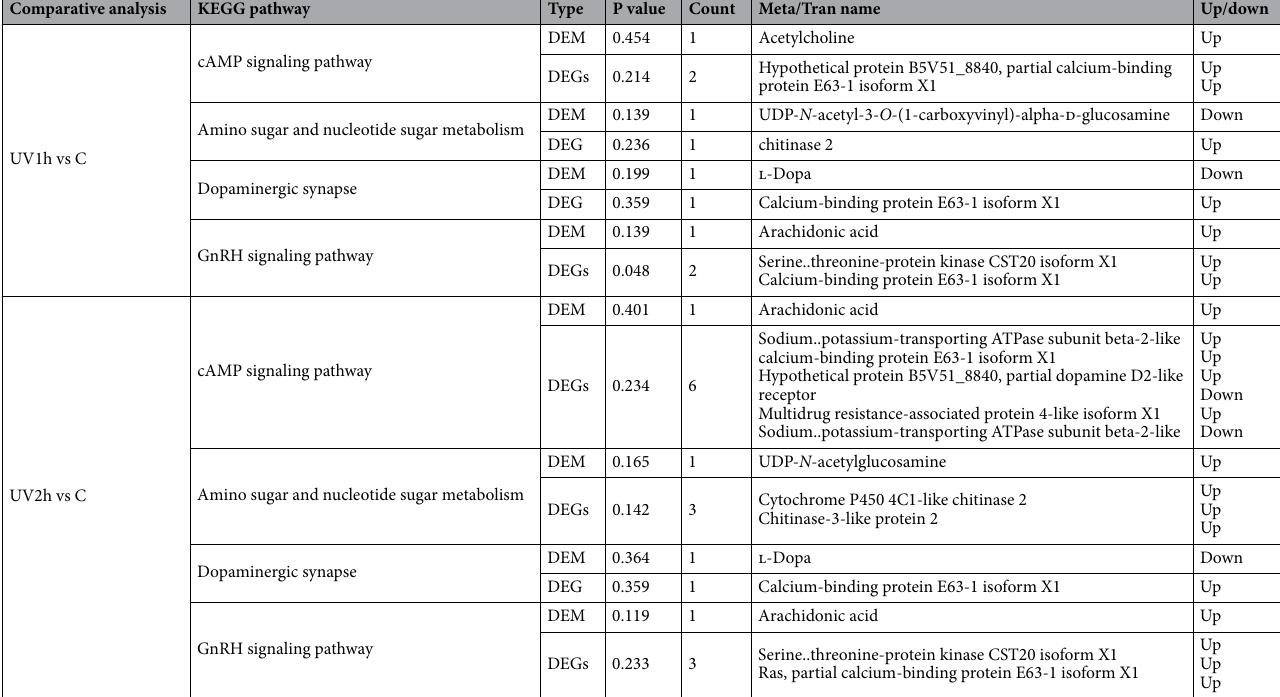
Table 4. List of common DEGs and DEMs in O. furnacalis under UV-A